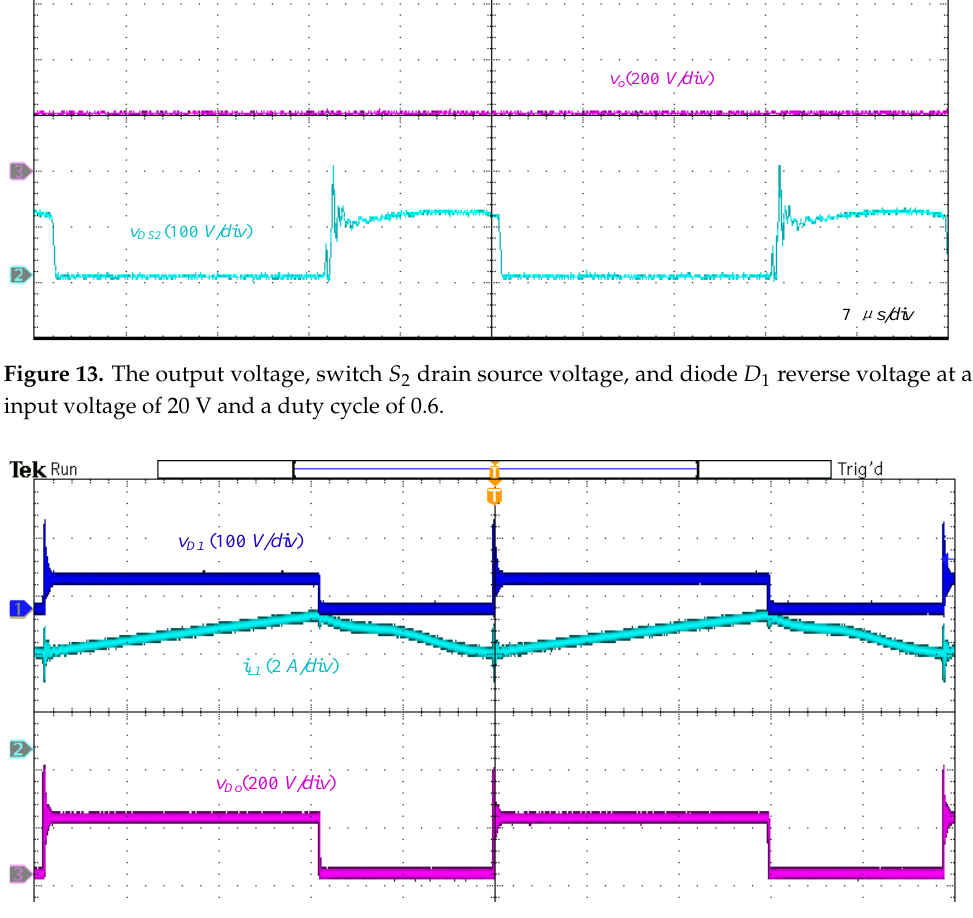
input voltage; the measured output voltage in this case is around 240 V. Figure 14. The inductor L 1 current, diode D 1 reverse voltage, and diode D o reverse voltage.